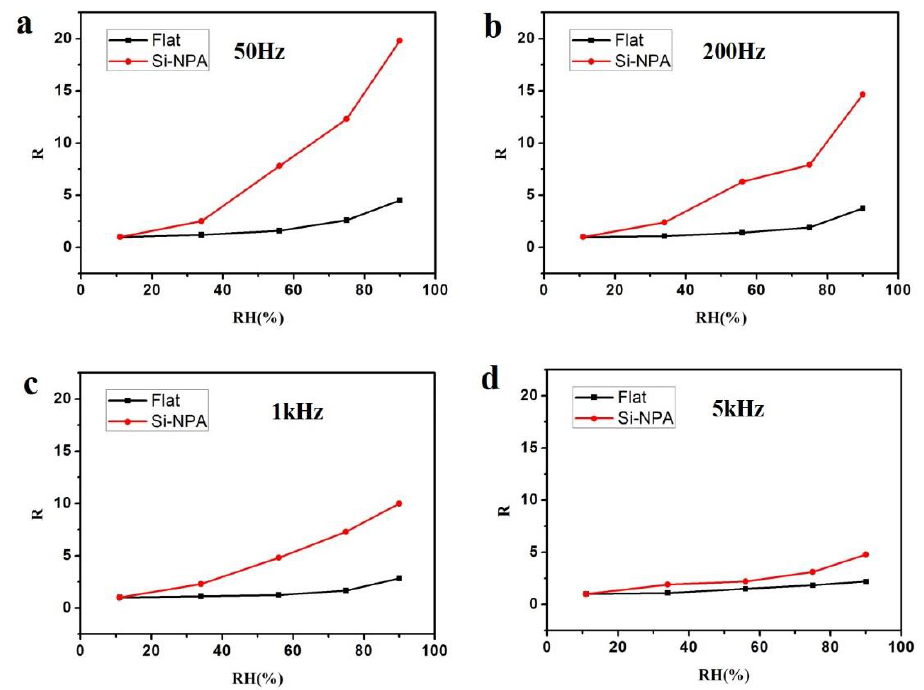
Figure 3. Humidity response curves measured under four frequencies: ( a ) 50 Hz, ( b ) 200 Hz, ( c ) 1 kHz, ( d ) 5 kHz.